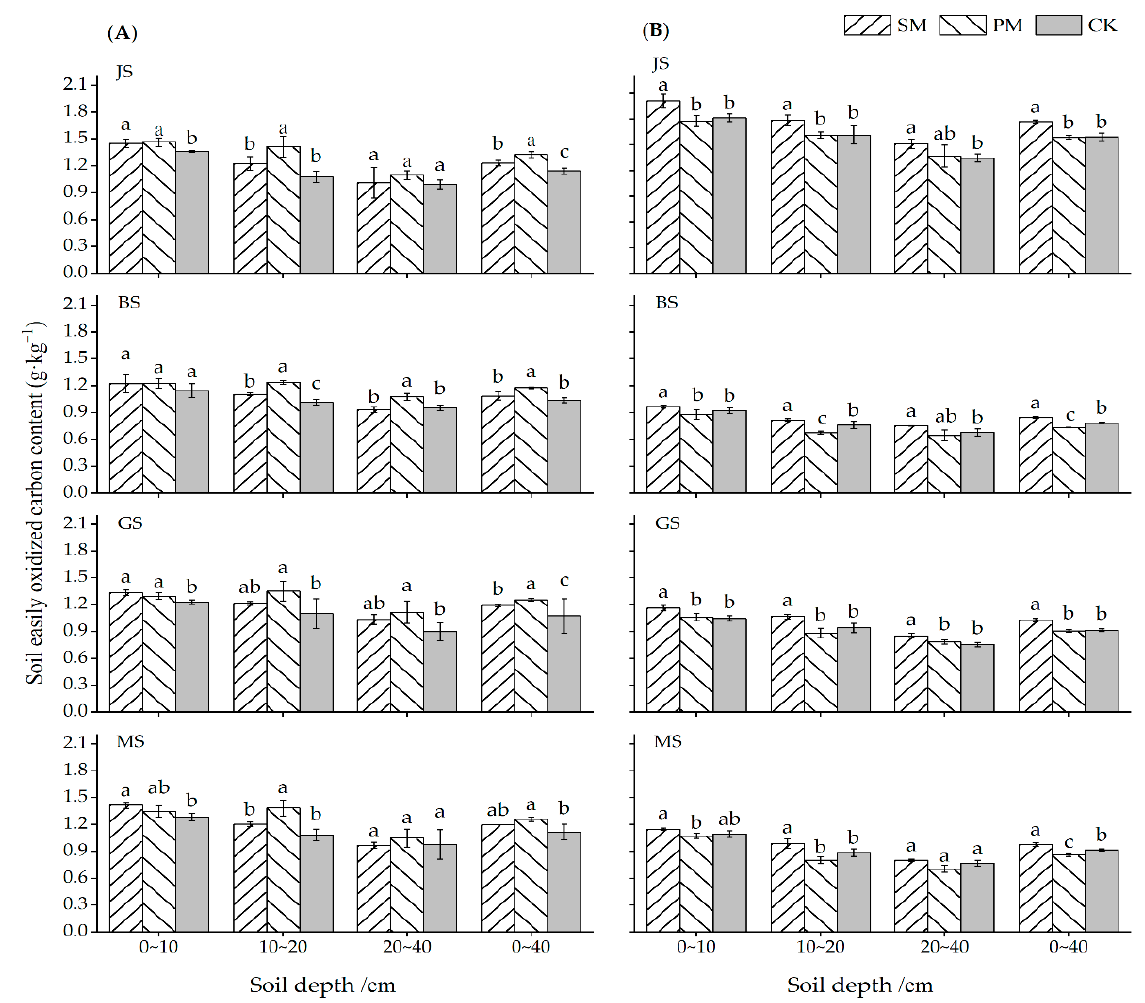
Figure 5. Soil easily oxidized carbon contents (EOC) at different growth stages of winter wheat. ( A ) 2019–2020; ( B ) 2020–2021. Lowercase letters denote significance at 5% significance level among treatments. SM: corn straw strip mulching; PM: plastic film mulching; CK: no mulching; JS: jointing stage; BS: blooming stage; GS: filling stage; MS: maturity stage.